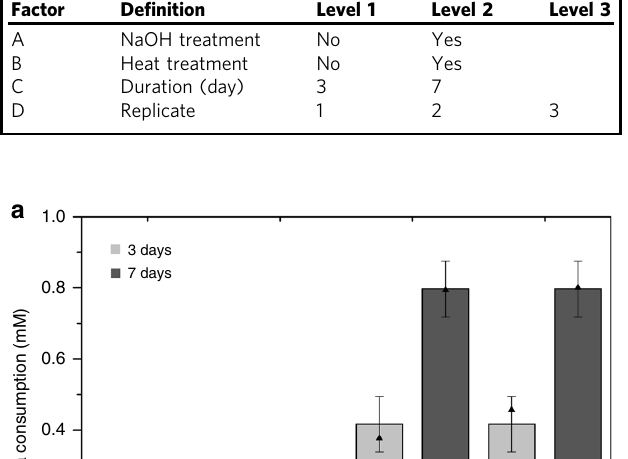
Fig. 5a. No statistically signi fi cant changes in Ca concentration is observed in the case of Ti and Ti HT. On the contrary, Ti NaOH and Ti NaOH HT powders induced CaP formation as a function of incubation time since a decrease in solution calcium